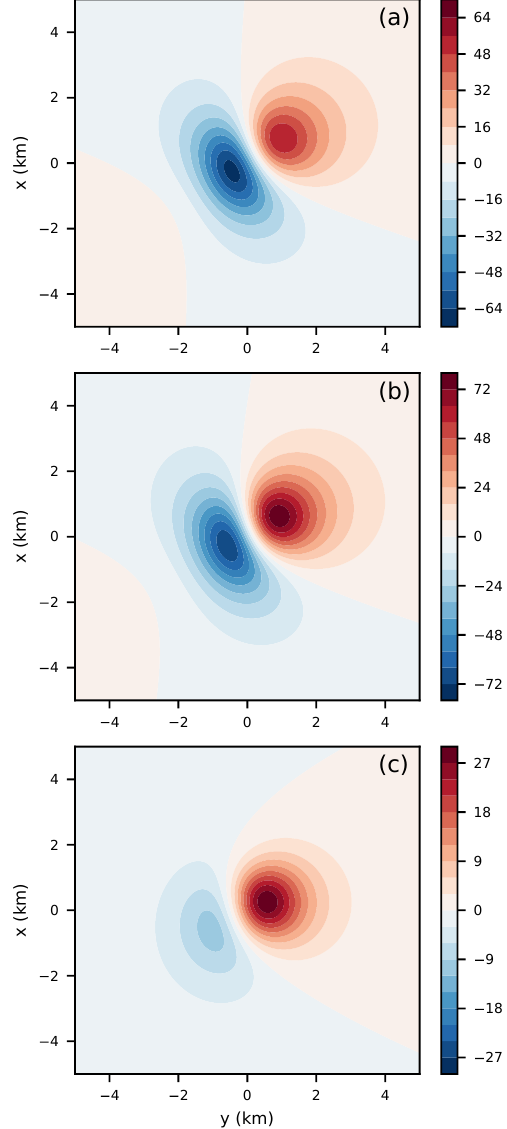
Figure 4. Total-field anomalies (in nT) produced by (a) Ellipsoid 1 and (b) Ellipsoid 2, both defined in Table 1. The synthetic data produced by these confocal ellipsoids were calculated on a regular grid of 200 × 200 points at the constant vertical coordinate z = 0m. These data were calculated with a uniform inducing field which is oblique to the semi-axes of the confocal ellipsoids. (c) Difference between the total-field anomalies shown in (b) and (a) .